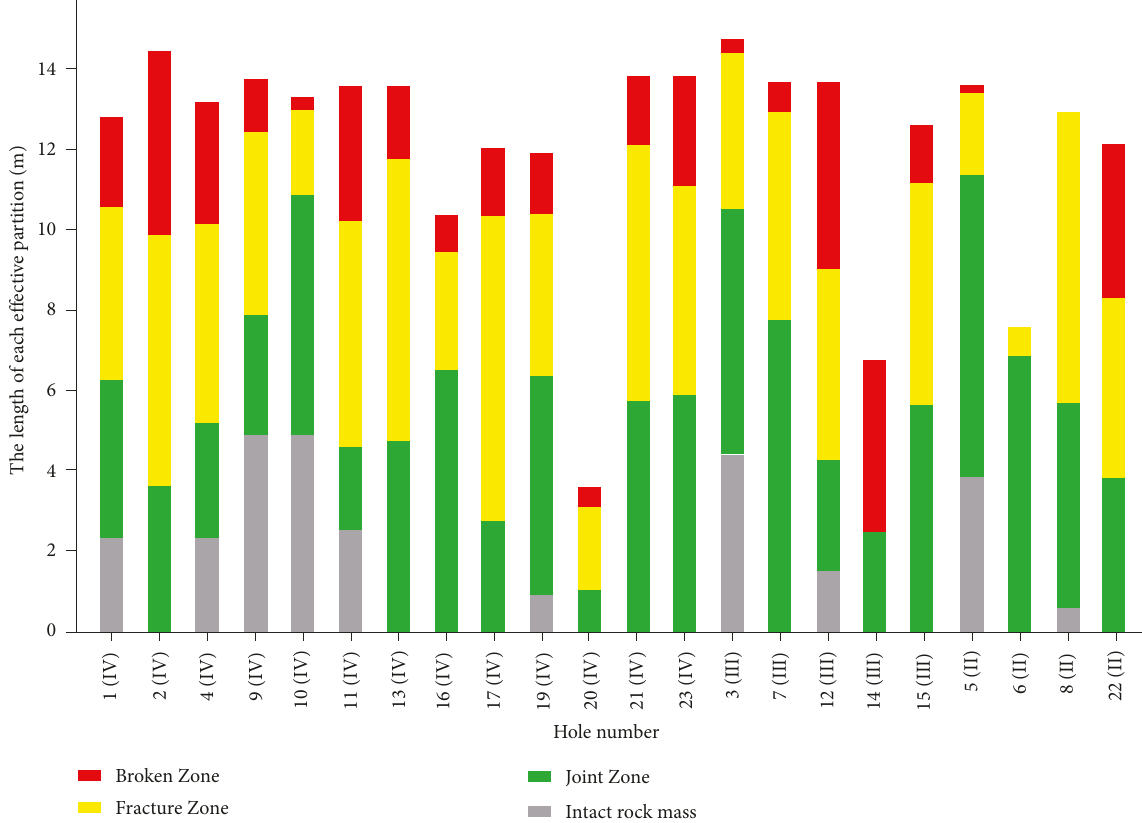
Figure 12: The length of each partition of every